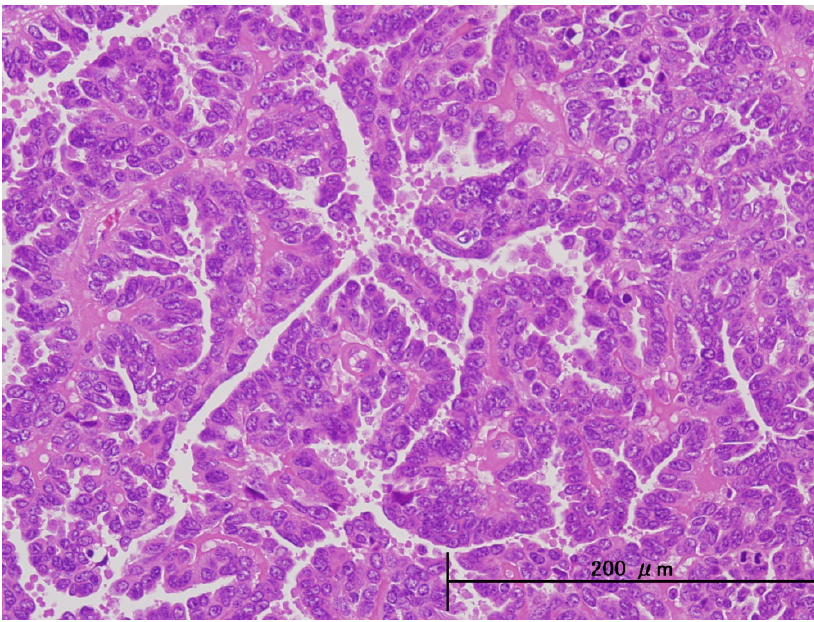
Figure 1. Endometrial serous carcinoma is characterized by high-grade cytological atypia in cells that do not share a common apical border. A papillary architecture is common.